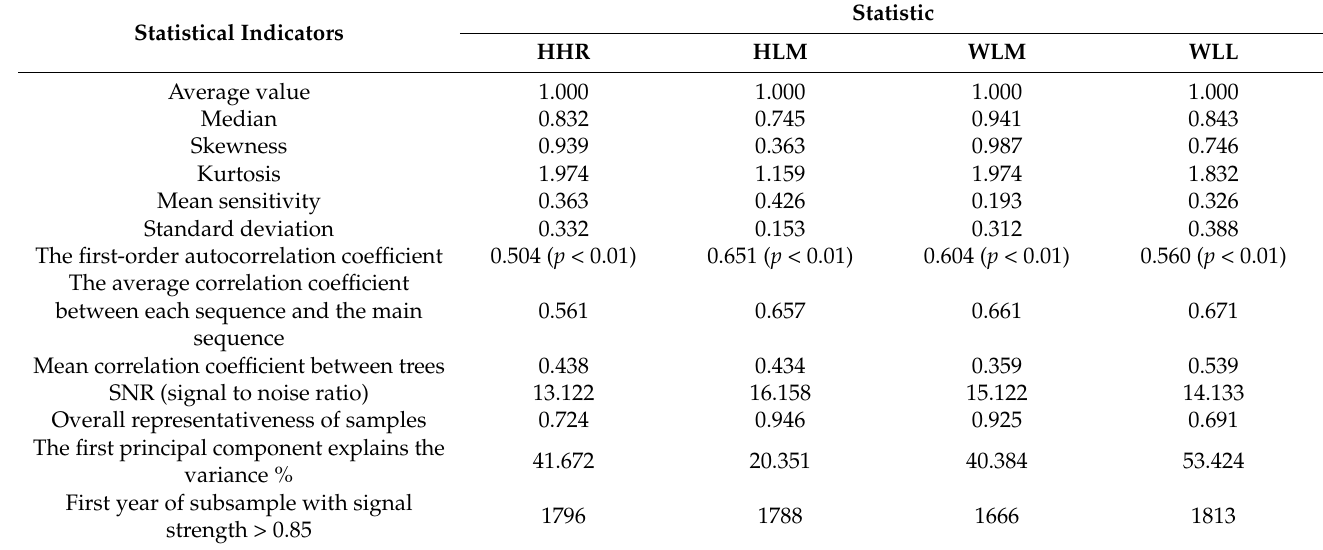
Table 2. Standard chronological table and statistical indices for different